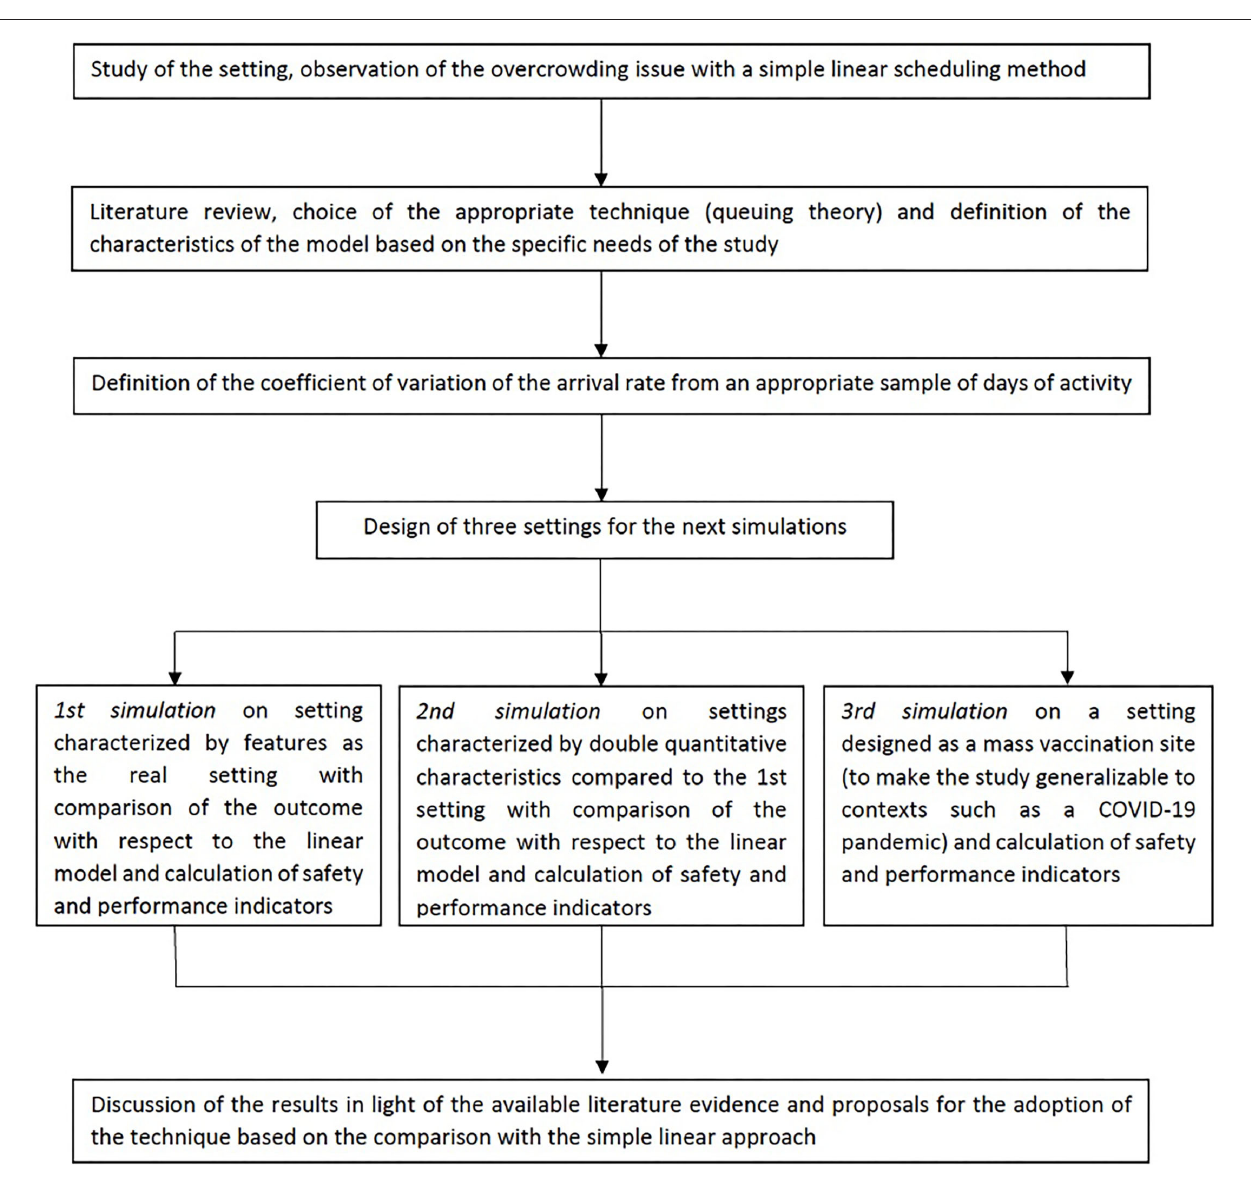
FIGURE 4 | Flow chart illustrating the study process